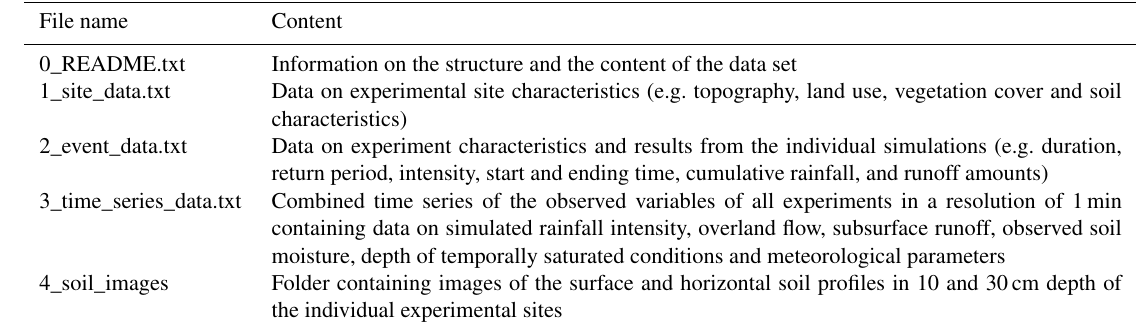
Table 3. Overview of the single files provided in the FreiDok data repository. All files are packed in a single ZIP